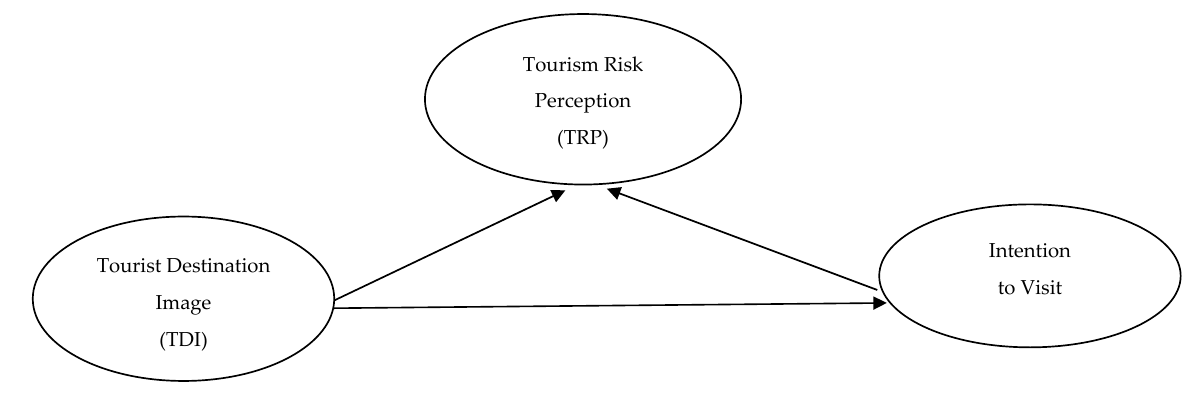
Figure 1. Research Model.